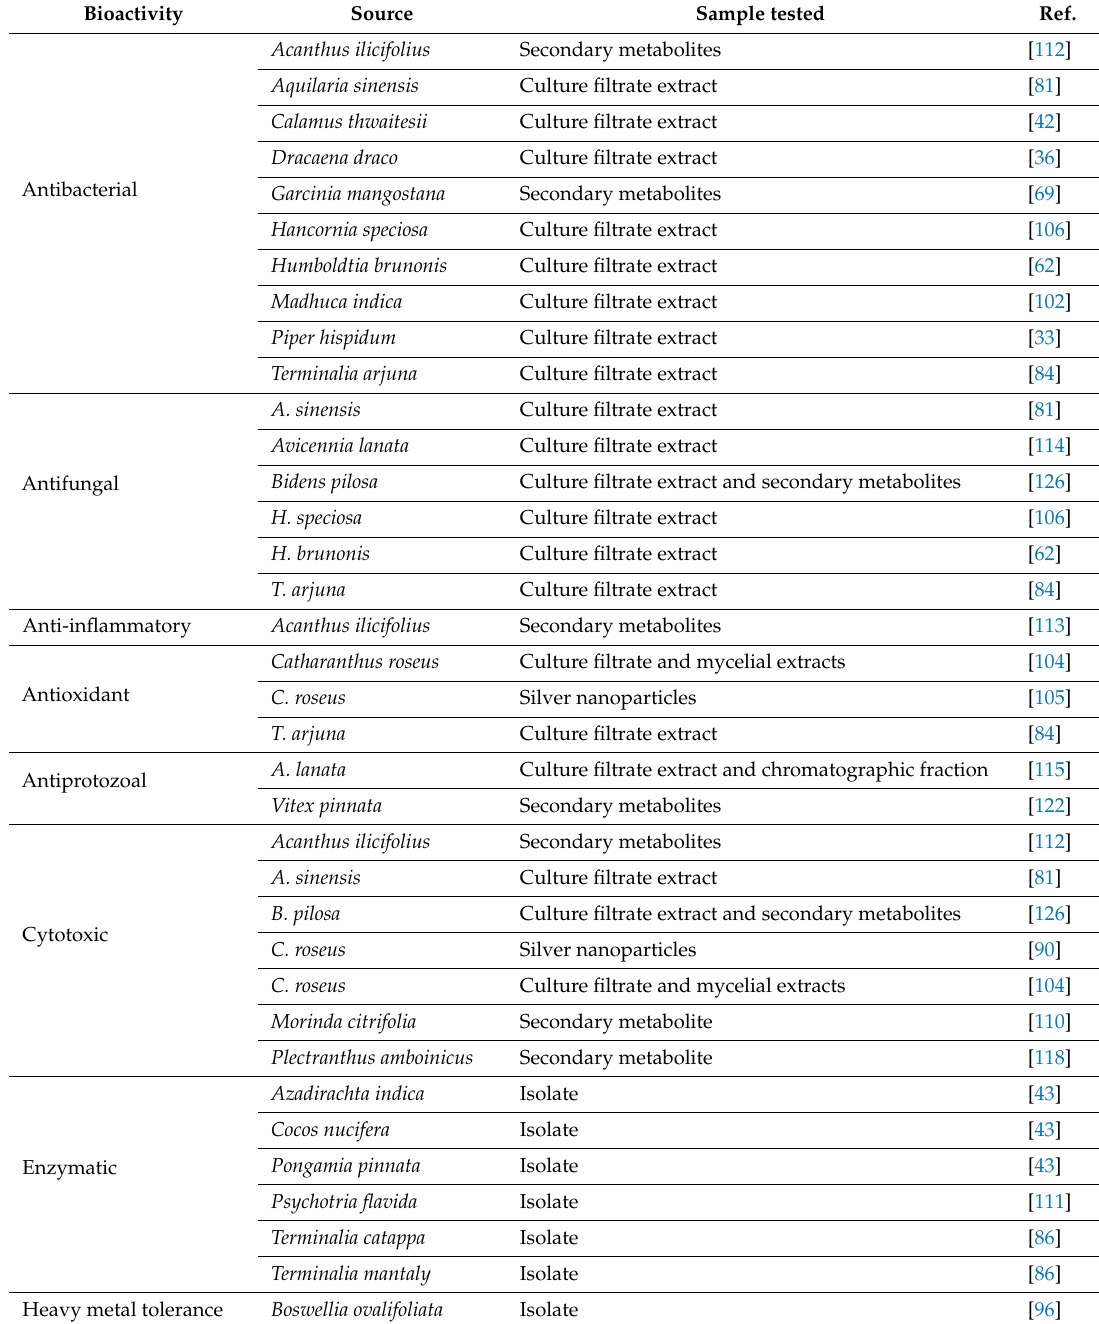
Table 2. Bioactivities of endophytic isolates of Lasiodiplodia theobromae